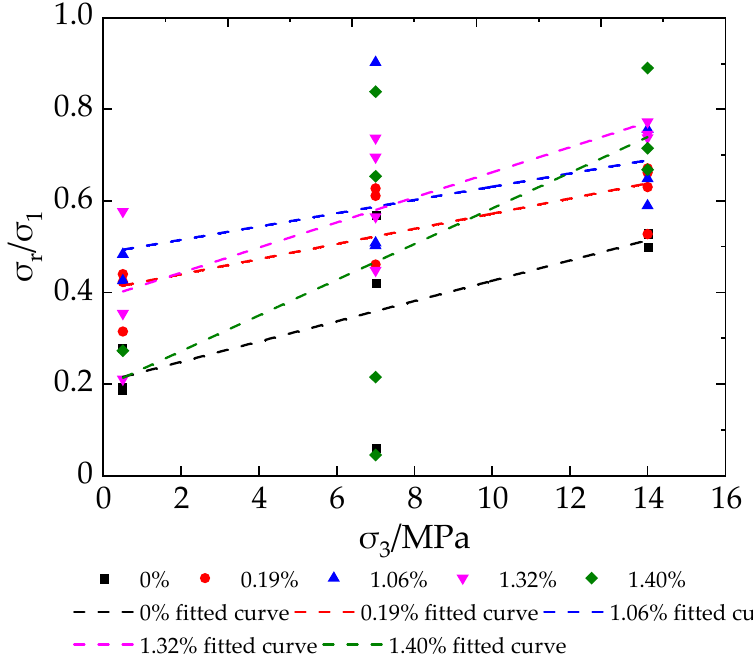
Figure 8. Residual strength vs. peak strength ratio.